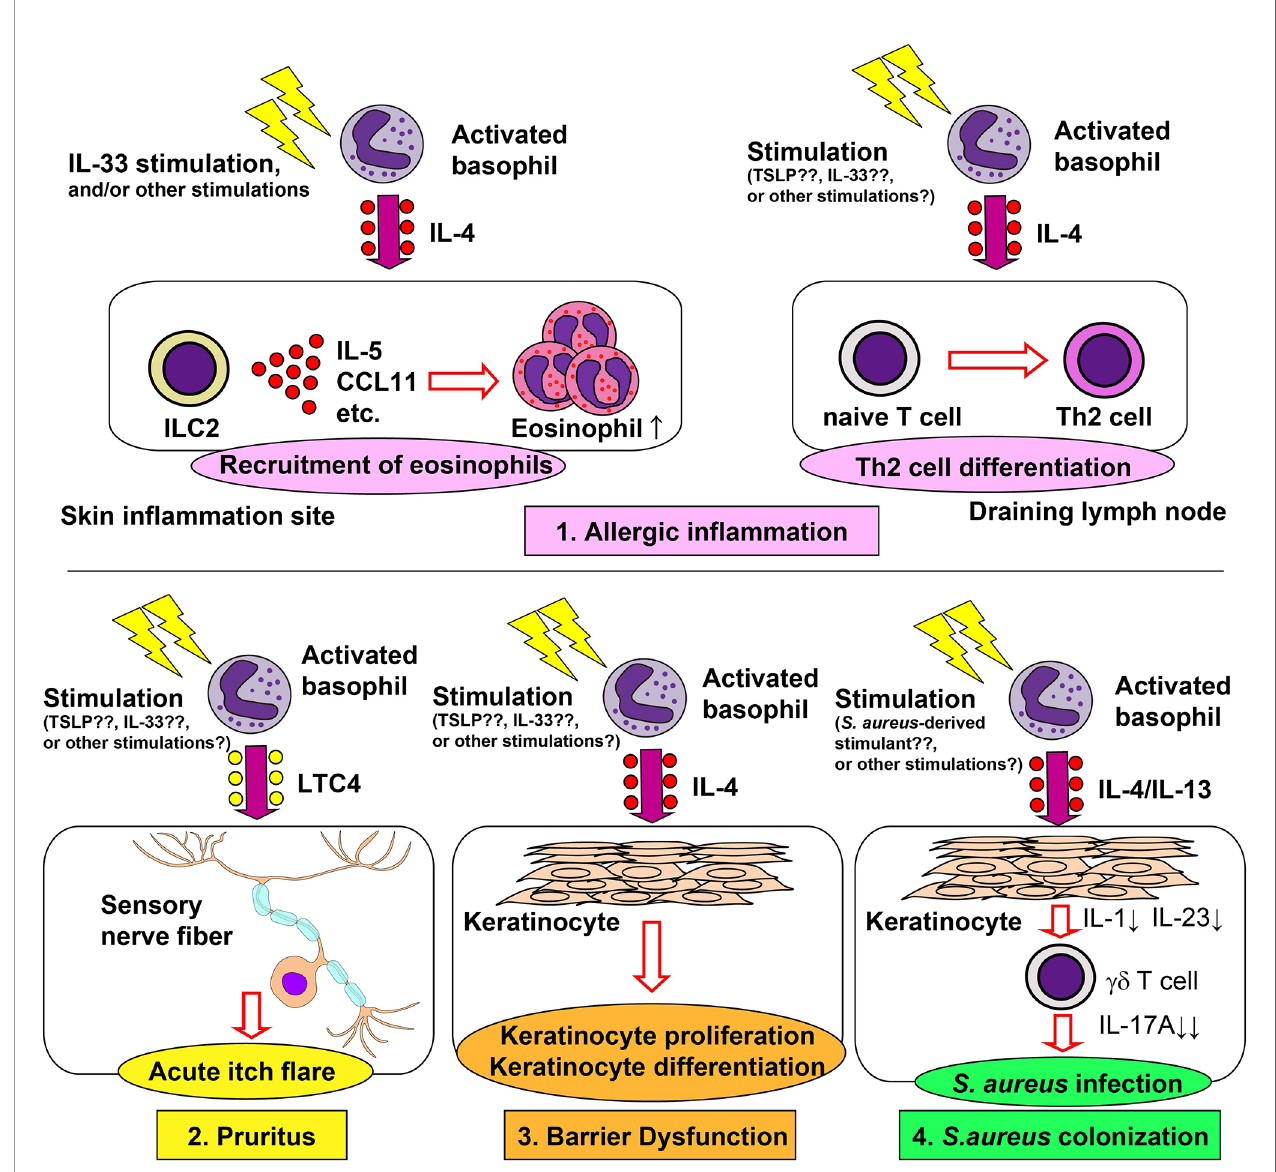
FIGURE 1 | Role of basophils in the pathogenesis of atopic dermatitis. Basophils contribute to allergic in fl ammation, pruritus, barrier dysfunction and Staphylococcus aureus colonization in atopic dermatitis (AD). 1) Basophil-derived interleukin (IL)-4 stimulates group 2 innate lymphoid cells (ILC2s) to enhance the production of IL-5 and CCL11, leading to enhanced recruitment of eosinophils to the skin lesion (upper left panel). Basophil-derived IL-4 also augments the differentiation of naïve T cells into Th2 cells in draining lymph nodes (upper right panel). 2) Basophil-derived leukotriene C4 (LTC4) acts on CysLTR2 + sensory neurons, inducing acute itch fl ares in AD (lower left panel). 3) Basophil-derived IL-4 promotes proliferation and differentiation of keratinocyte (lower middle panel). 4) Basophil-derived IL-4 suppresses the IL-1 and IL-23 production by keratinocytes, leading to reduced production of IL-17A by gd T cells and, therefore, increased susceptibility to S. aureus infection (lower right